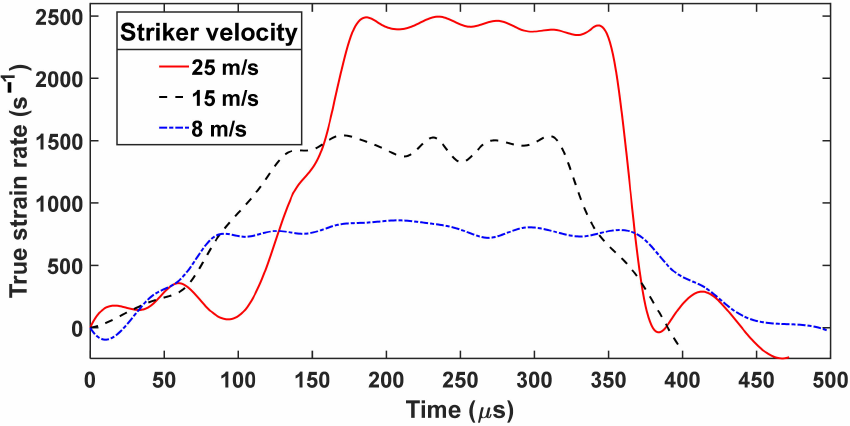
Figure 6. Strain rate-time graphs generated at different SHPB striker bar velocities.